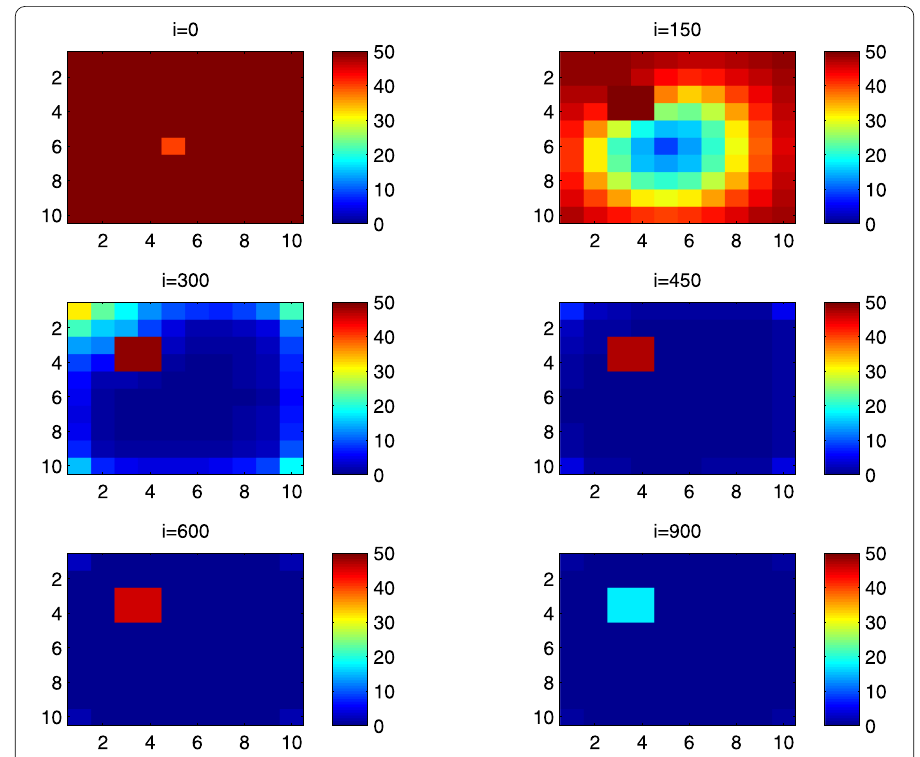
Figure 9 S Cpq behavior in the presence of optimal controls (11). The case when the disease starts from the center of (cid:2)